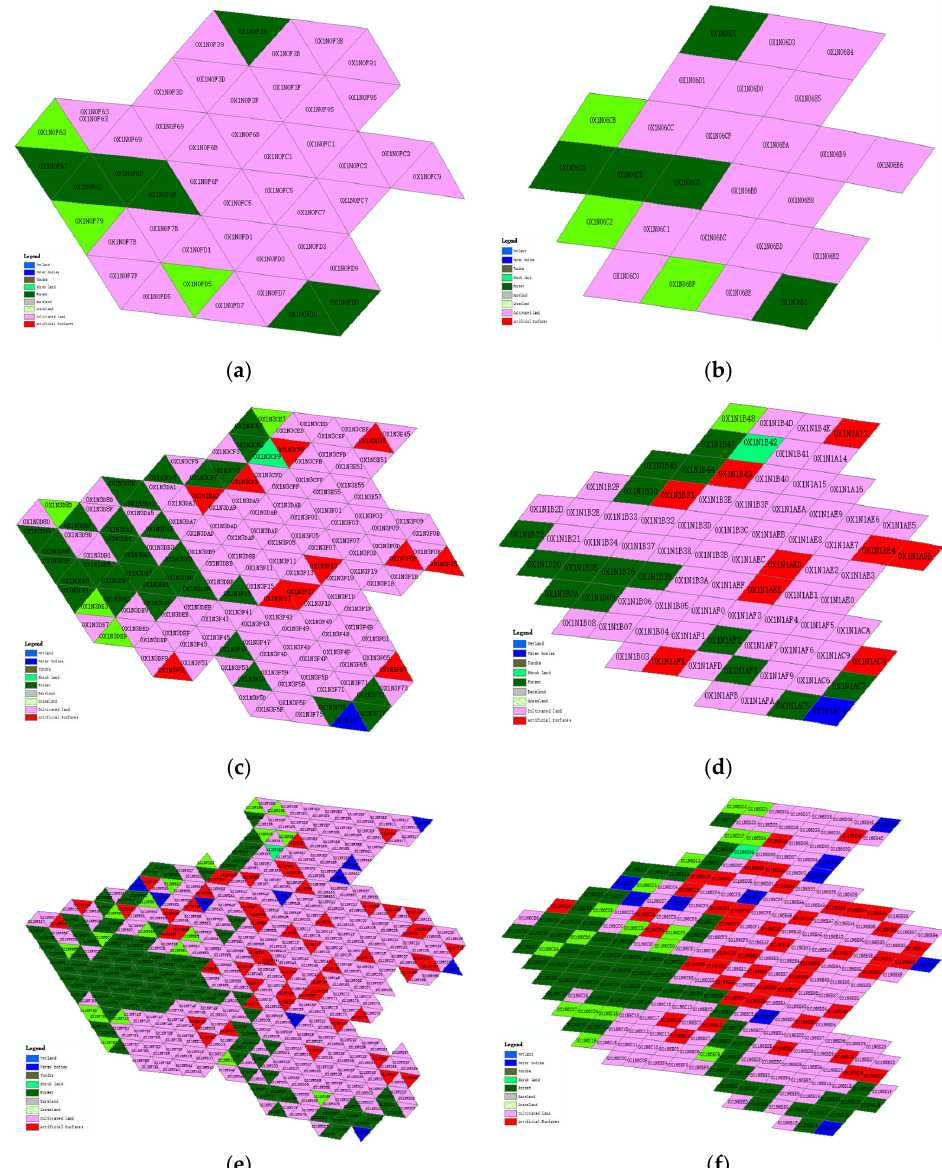
Figure 15. The different grid codes of the sixth, seventh and eighth levels of Globeland30 land coverage data in Henan Province before and after TtoDcode conversion. ( a ) The sixth level triangle grid code of land coverage data in Henan Province, ( b ) The sixth level TtoDcode diamond grid code of land coverage data in Henan Province, ( c )The seventh level triangle grid code of land coverage data in Henan Province, ( d ) The seventh level TtoDcode diamond grid code of land coverage data in Henan Province, ( e ) The eighth level triangle grid code of land coverage data in Henan Province, ( f ) The eighth level TtoDcode diamond grid code of land coverage data in Henan Province.